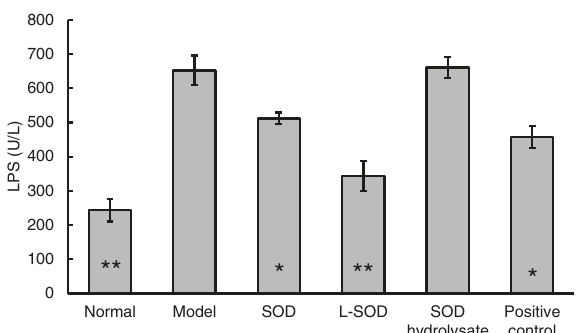
Fig. 8 LPS level in the fasting plasma of normal or T2D model rats after 4-week intervention. The data are presented as mean ± SD, n = 6 each group. * P < 0.05, ** P < 0.01 vs. model